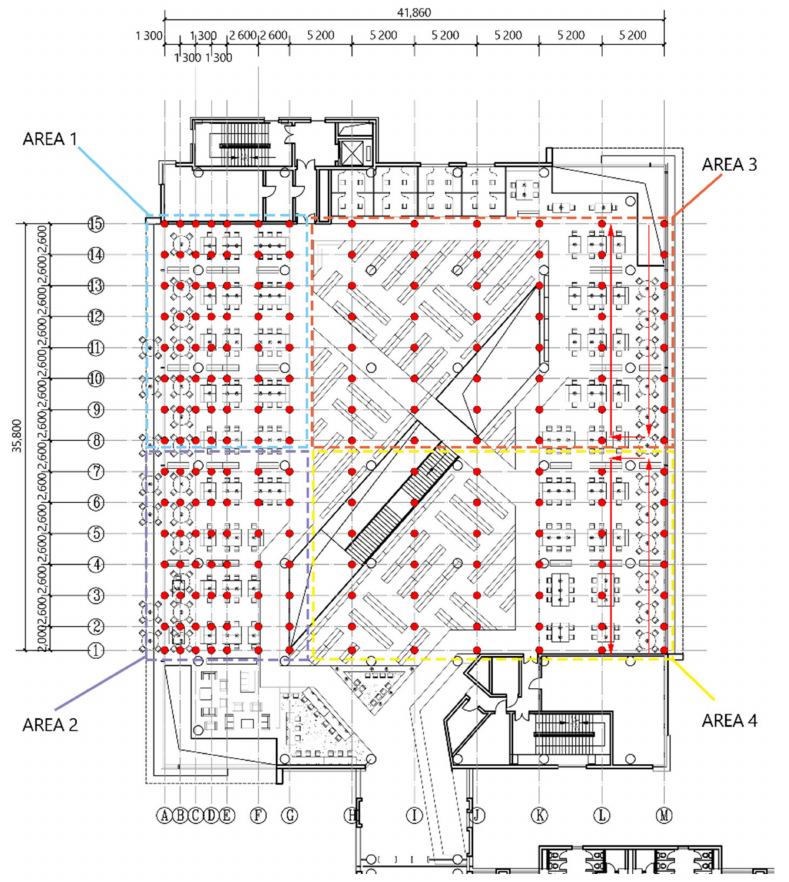
Figure 10. The measuring point layout of